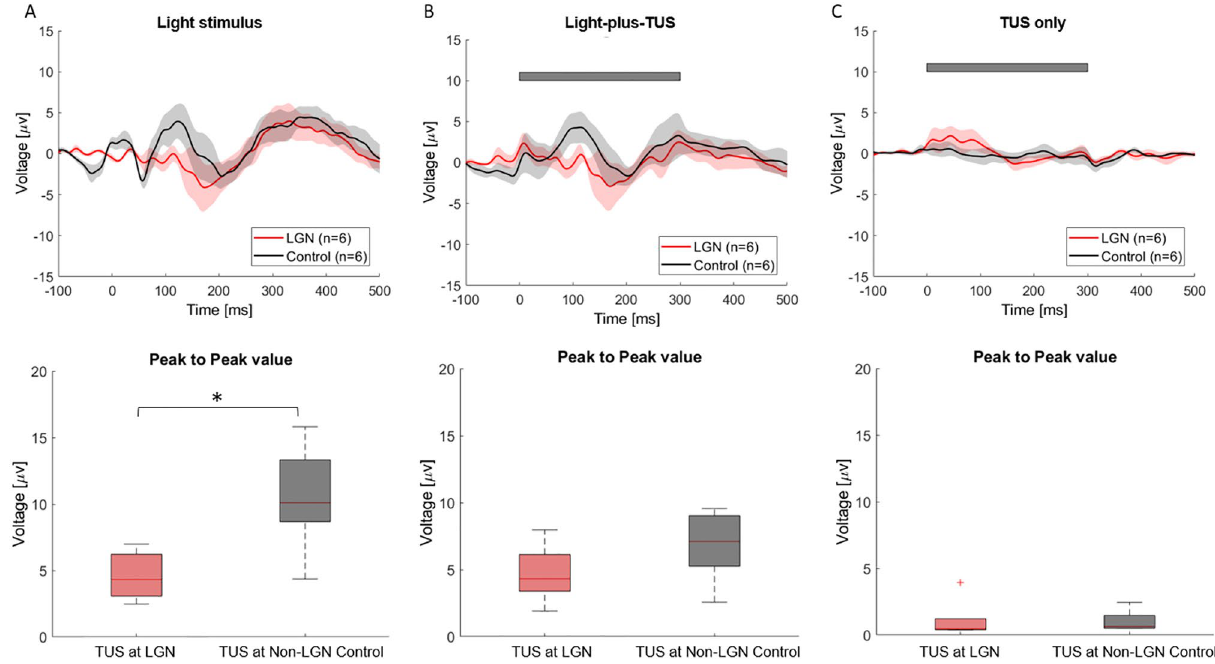
Figure 3. The impact of LGN TUS on VEPs outlasts the duration of sonication. Effect of LGN (red) and non-LGN control (gray, 10–15 mm anterior of LGN) sonication on VEPs for the three interleaved stimulus conditions (Light-only, Light-plus-TUS and TUS-only). ( A ) Top row: Mean + /- SEM VEP waveforms in the Light-only condition for LGN (red line, N = 6) and non-LGN control (gray line, N = 5) sonication. Responses were smoothed (15-point moving averages filter) for illustration purposes. Bottom row: Boxplots of VEP Peak- to-peak amplitude for LGN and non-LGN control sonication, light-only trials. (* p = 0.004, one-tailed unpaired t-test). Box depicts interquartile range, and dashed error bars depict full range of values. ( B ) Data presented as in A, but for the light-plus-TUS condition. Gray bar illustrates time course of TUS relative to visual stimulus onset. Difference between LGN and non-LGN: p = 0.07. ( C ) Data presented as in A, for the TUS-only condition (i.e., no visual stimulus). Note the minimal overall response, indicative of little-to-no nonspecific auditory or somatosensory responses to transducer vibration. The transient ~ 100 ms increase in voltage at TUS onset with LGN stimulation, is primarily due to responses in a single animal (see outlier dot in bottom row), indicative potentially of a subtle depolarizing effect of LGN-TUS in this animal, and/or an EEG artifact of Activation of the US transducer can induce an electromagnetic interference on the electrodes. The proper- ties of the ultrasound artifact were quantified with experiments in which a rectangular block of tofu was used as a phantom with 5 EEG electrodes inserted and the ultrasound transducer placed directly on the surface. The frequency spectra of the EEG are shown in Fig. 5C with the artifact shown as a signal commensurate with the TUS signal. When the transducer was removed from the surface and positioned at increasing distances, the magnitude of the artifact decreased as the transducer distance increased. This suggests that the source of the artifact was due to electromagnetic coupling of the transducer to the electrodes. Figure 6 illustrates differences between spectra in Fig. 5A and B. The differences are shown as spectral differ- ence maps (upper row) for two conditions, light-only and light-plus-TUS at LGN (Column 5A) and light-only and light-plus-TUS at the non-LGN control location (Column 5B). Each of the two conditions contains differ- ence maps for NPL and PL analyses. A nonparametric permutation-test statistic was performed (not corrected for multiple comparisons) on the difference maps between the spectrograms with differences that were statisti- cally significant (lower row). During TUS of the LGN, significant differences in the NPL analysis were seen in the upper beta and low gamma frequency bands (30–50 Hz) at approximately 90 and 300 ms post-sonication. By contrast, in the PL analysis, significant difference was seen in the lower frequency theta and alpha bands between 90 to 300 ms. During TUS of the non-LGN control (a portion of the medial putamen and immediately adjacent internal capsule), a statistically significant reduction in the theta and alpha activity of the NPL response was observed, with no clear change in the PL response. There was no significant difference between the spectra of LGN and Non-LGN control sonication during TUS-only condition. A nonparametric statistical test was performed on the difference map between the phantom data (Fig. 5C) and the light-only baseline condition. The black contours in Fig. 6A (lower row) show the significant regions due to TUS in phantom (tofu). There is a slight overlap in low frequency (< 10 Hz) content of PL activity during the application of TUS, whereas there is no overlap in the significant regions of NPL activity, indicating that the observed effects of TUS on gamma- beta frequency powers are unlikely to be due to temporal properties of the transducer’s electromagnetic artifact.